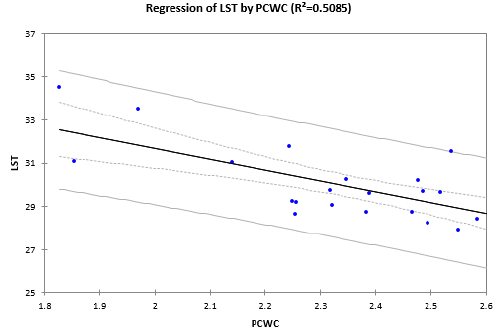
Figure 12. Correlation of monthly mean LST derived from MODIS and monthly computed